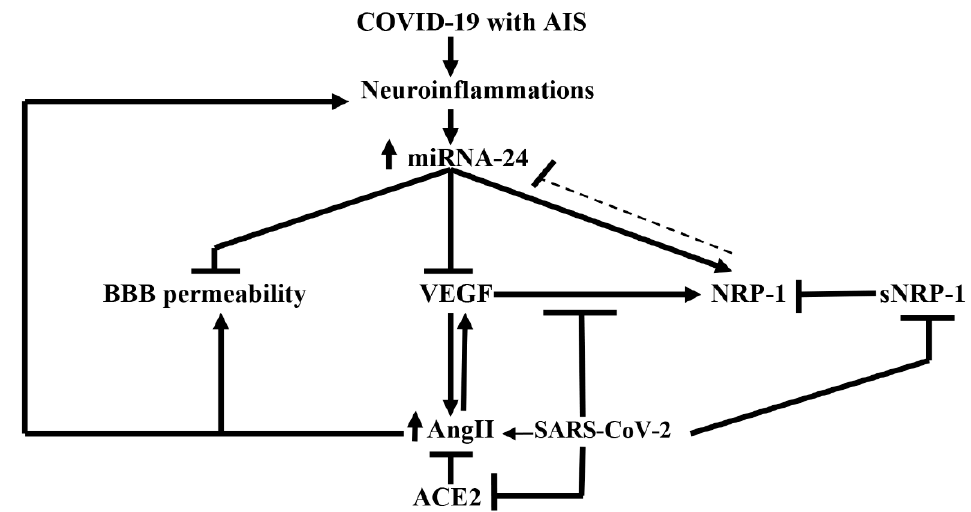
Figure 8. Role of miRNA-24 in COVID-19 with acute ischemic stroke (AIS): COVID-19 with AIS induces neuroinflammation and the release of miRNA-24, which inhibits blood–brain barrier permeability and the release of vascular endothelial growth factor (VEGF) with induction expression of NRP-1. The interaction between VEGF and NRP-1 is inhibited by SARS-CoV-2 leading to high NRP-1, which suppresses miRNA-24. SARS-CoV-2 inhibits soluble NRP-1(sNRP-1), an antagonist of NRP-1; moreover, SARS-CoV-2 increases angiotensin II (AngII), which induces neuroinflammation and increases the permeability of BBB. SARS-CoV-2 downregulates angiotensin-converting enzyme 2 (ACE2), which metabolizes AngII.